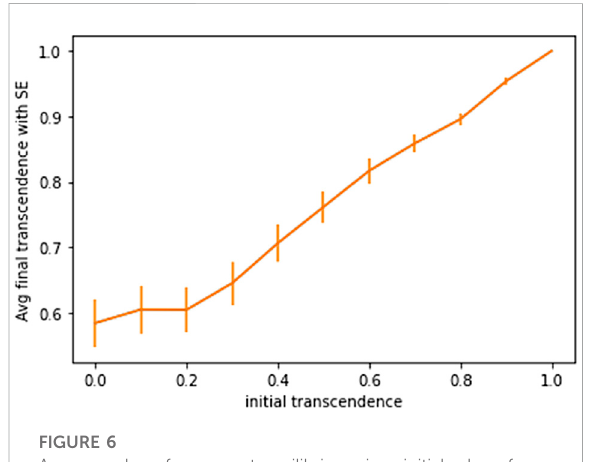
FIGURE 7 Distance to adversarial and non-adversarial